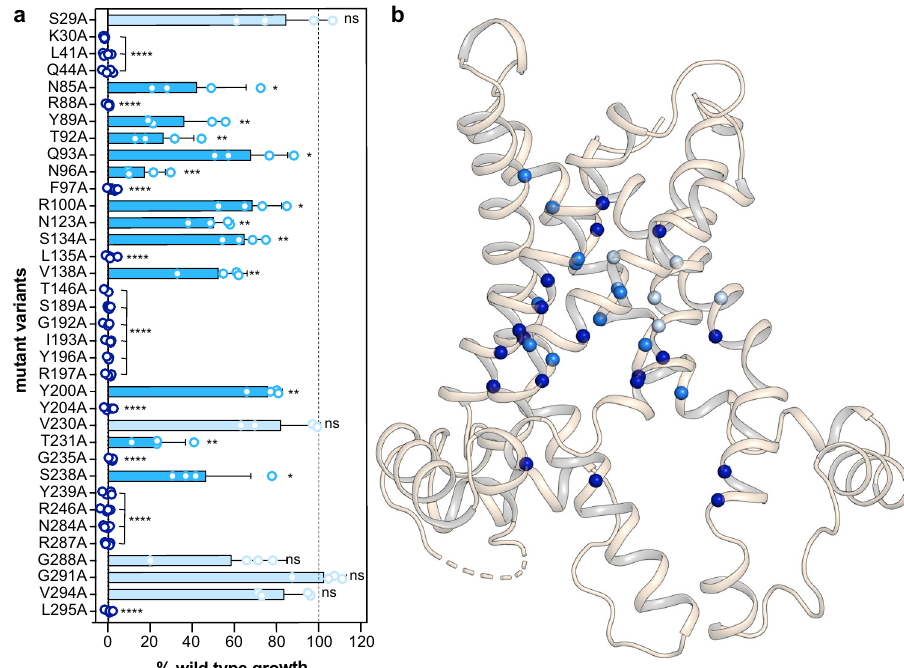
Fig. 2 Most residues of the translocation pathway are critical for function. a Percentage of functional complementation of the WB-12 strain expressing TtAac variants compared to expressing the wild-type carrier (100% complementation), as determined by densitometry of serial dilution spot tests on YPG medium (Supplementary Fig. 2). The bars and error bars represent mean and standard deviation of four independent experiments. Signi fi cance analysis was performed with two-tailed one-sample t -tests, as described in “ Methods ” ( p > 0.05, ns; p ≤ 0.05, *; p ≤ 0.01, **; p ≤ 0.001, ***; p ≤ 0.0001, ****). Colours represent the three observed growth properties: growth not affected signi fi cantly (ns), light blue; growth signi fi cantly affected (0.5 ≥ p > 0.0001), marine; no growth ( p ≤ 0.0001), dark blue. b Position of the analysed residues in the matrix-open BKA-bound TtAac structure (PDB code: 6gci chain A), shown as a cartoon representation. Spheres represent the CA carbon atoms and are colour-coded as described in a . Source data for this fi gure are provided as a Source Data fi